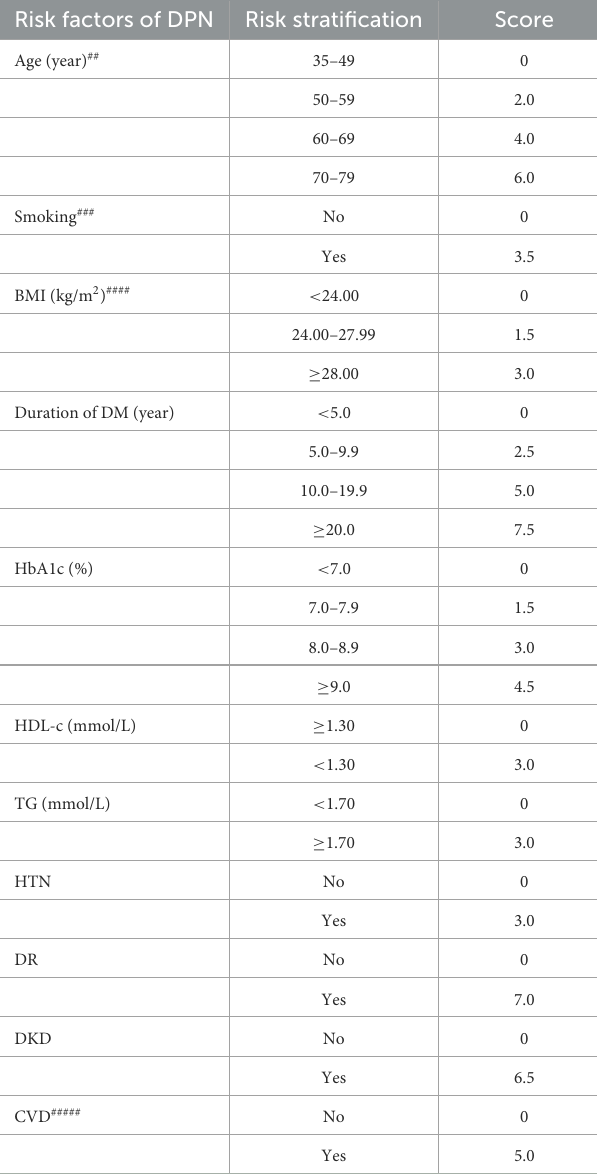
TABLE 1 Risk prediction model for DPN #